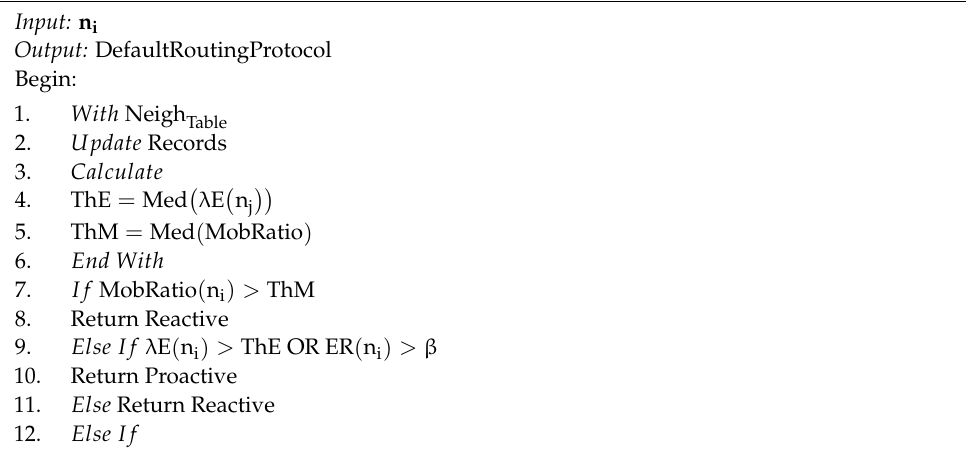
Algorithm 1: Selection of Default Routing